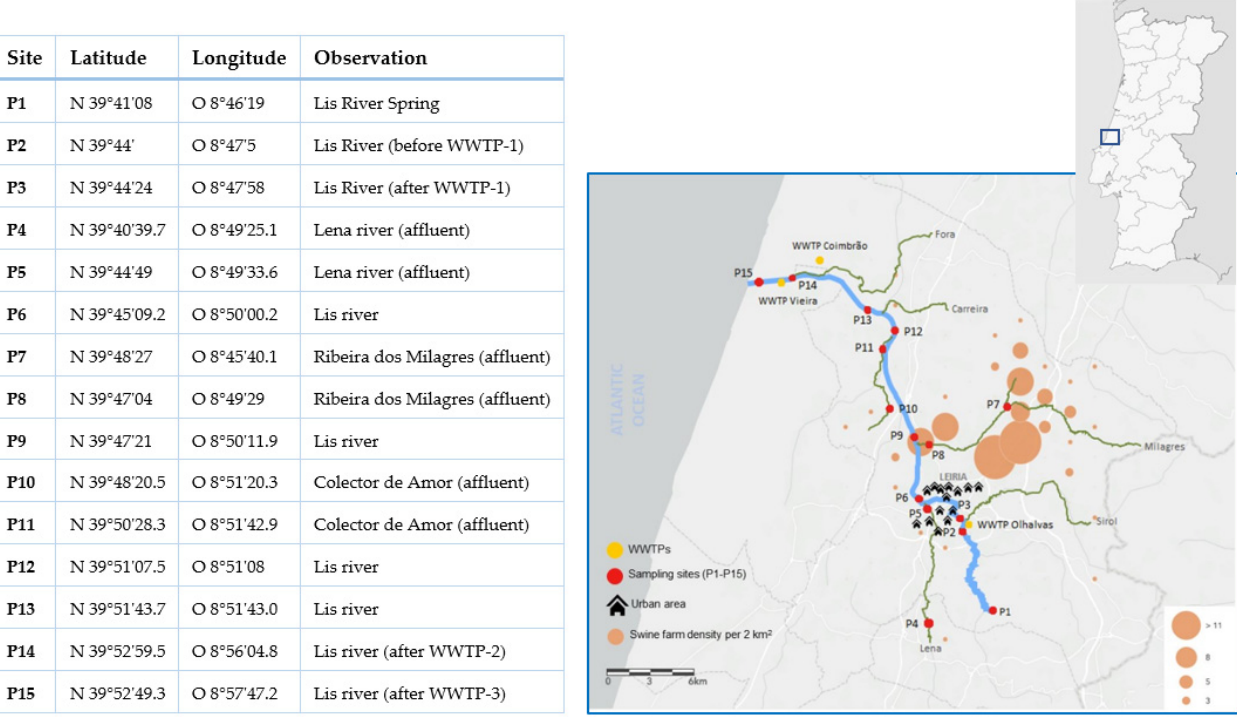
Figure 1. Sampling sites (P1–P15), coordinates, and other information and map showing sites (red dots) located in the Lis River main course (P1–P3, P6, P9, P12–P15) and tributaries (P4, P5, P7, P8, P10). WWTPs are indicated using yellow dots and the density of swine farms is in orange (from Teixeira et al., 2022